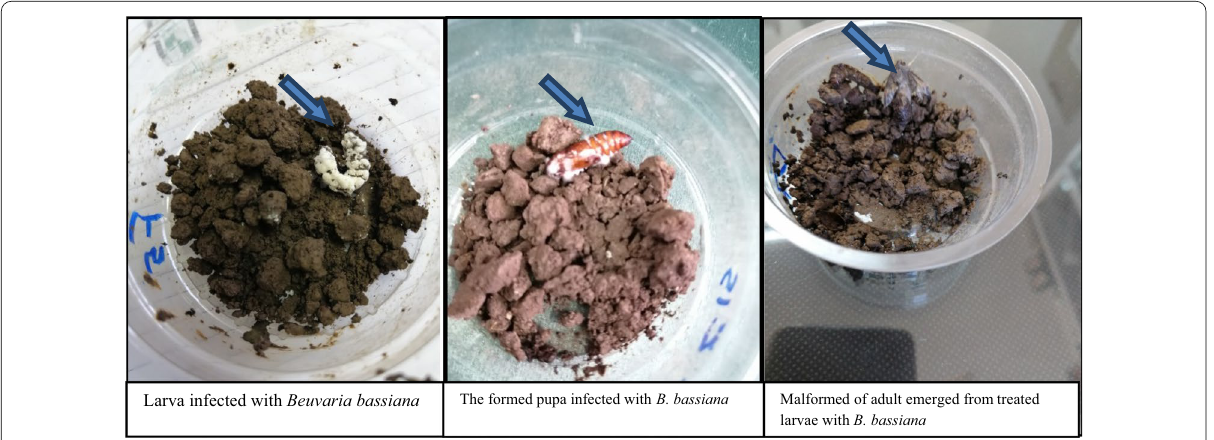
Means with different letters are significantly different at P < 0.05.